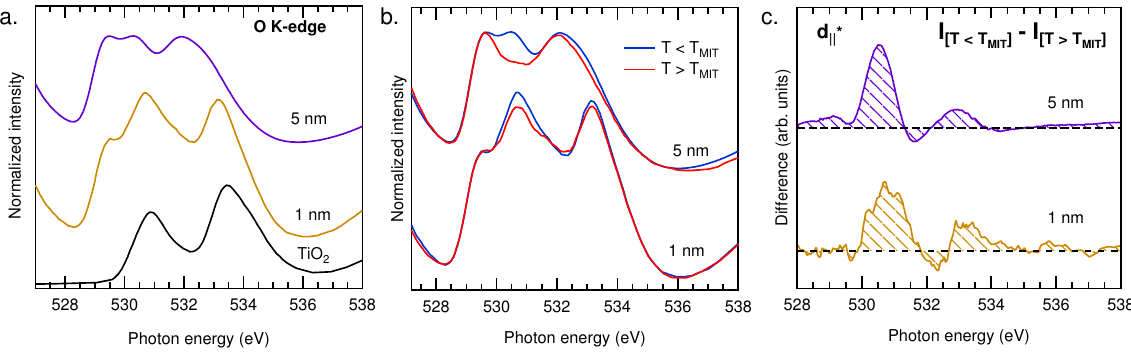
Figure 7. ( a ) O K-edge XAS from two VO TiO single-crystal reference; ( b ) O K-edge XAS from the same two VO 2 above (red) and below (blue) T K-edge measurements for the two